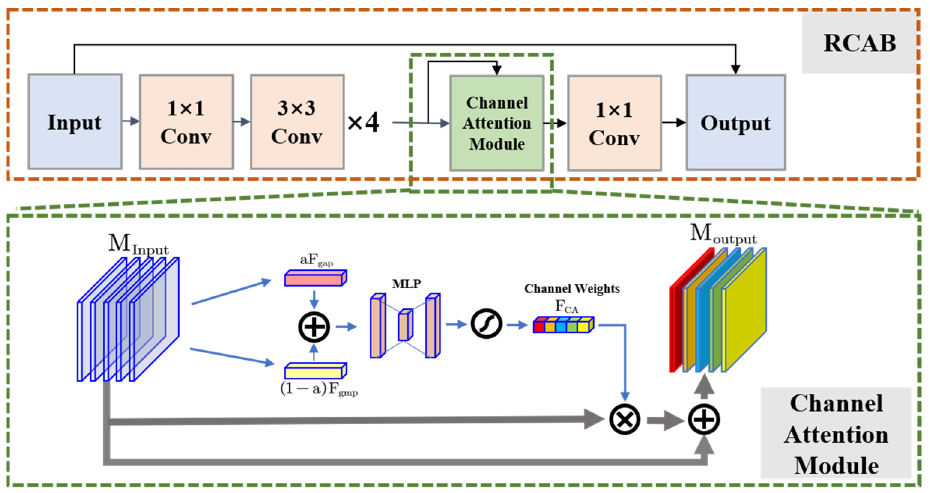
Figure 3. The structure of an RCAB and its channel attention module.